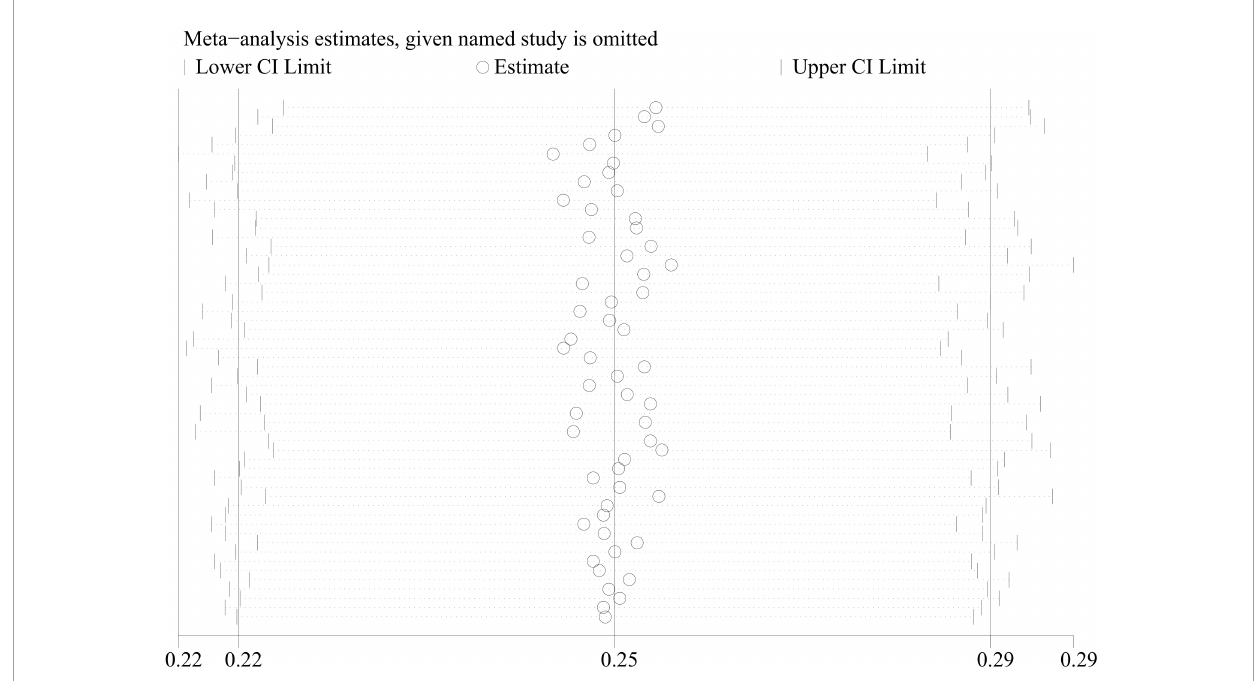
FIGURE3 Sensitivity analysis of studies on the prevalence of sarcopenia in COPD patients in